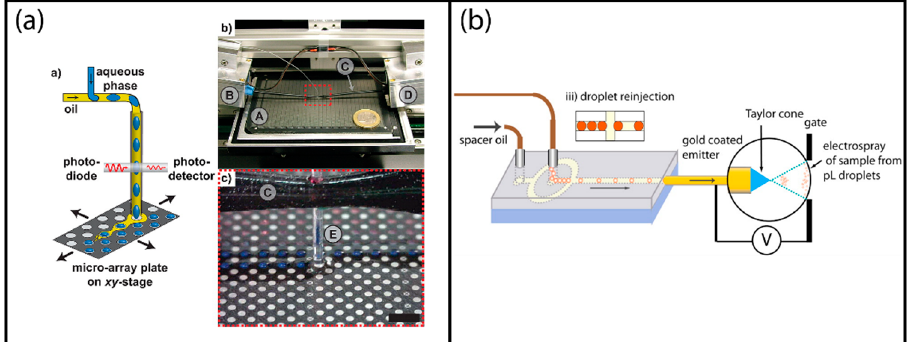
Figure 8. Examples of label-free mass spectroscopic droplet detection: ( a ) Matrix-assisted laser desorption/ionization (MALDI) MS analysis of segmented droplets transferred on a MALDI plate; reprinted with permission from [95]. American Chemical Society (2013). ( b ) Direct electrospray ionization (ESI) MS analysis of surfactant-stabilized segmented droplets; adapted with permission from [102]. American Chemical Society (2013).